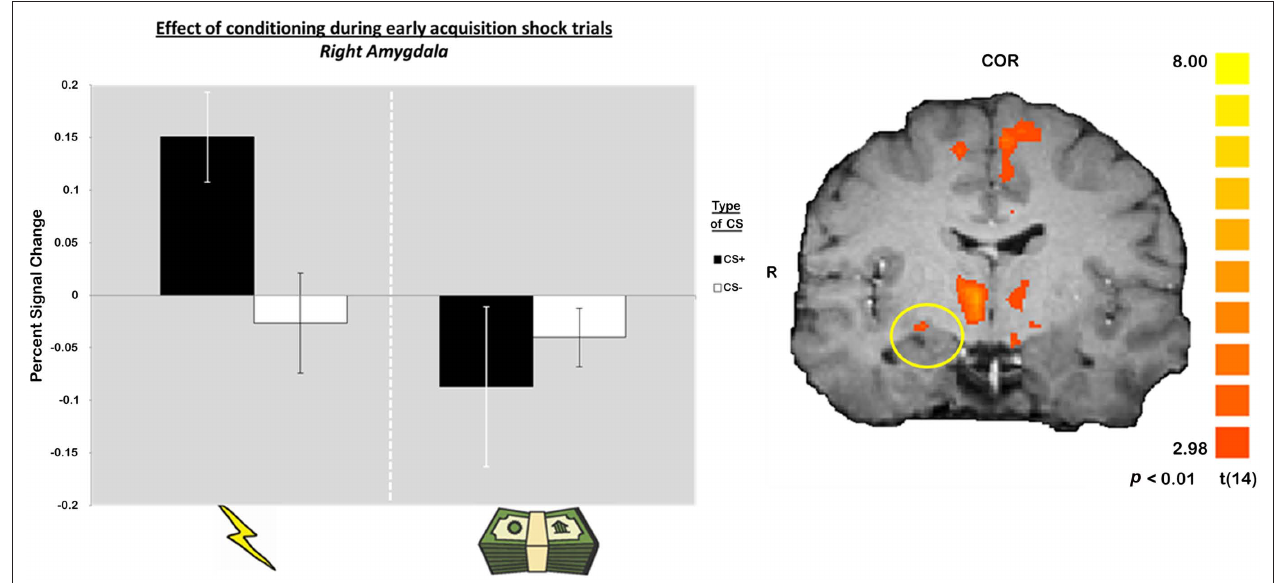
Figure 4 | Blood oxygenation level dependent signals in the amygdala during early acquisition reveal a differential response between CS + and CS − during the primary, but not the secondary aversive conditioning